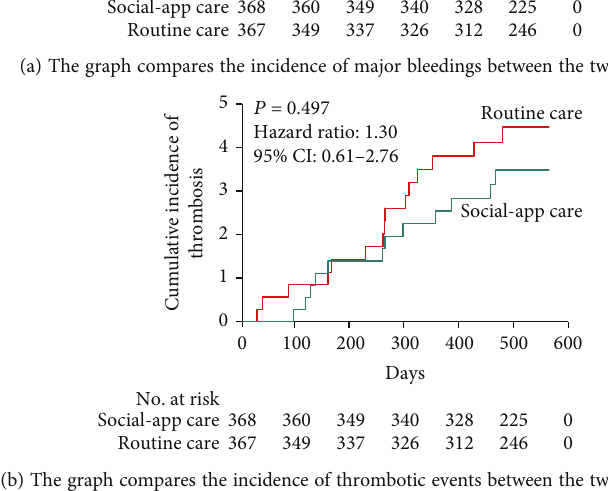
Figure 3: Kaplan-Meier analysis of the cumulative incidence of events. Table 3: Determinants of high TTR levels ( > 70%) by logistic regression